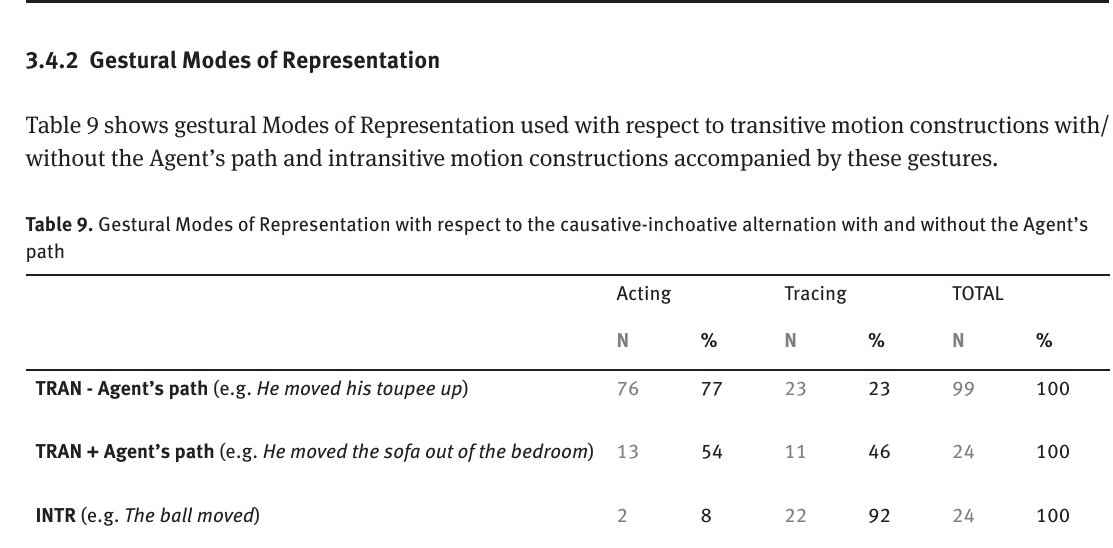
With Rep. Without